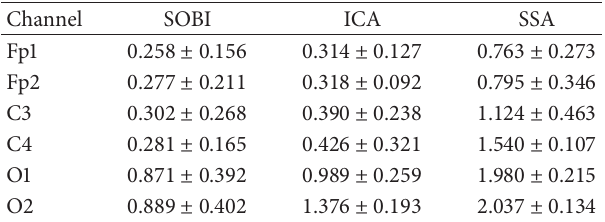
Table 2: MI by different EOG artifact correction methods over 20 real EEG data